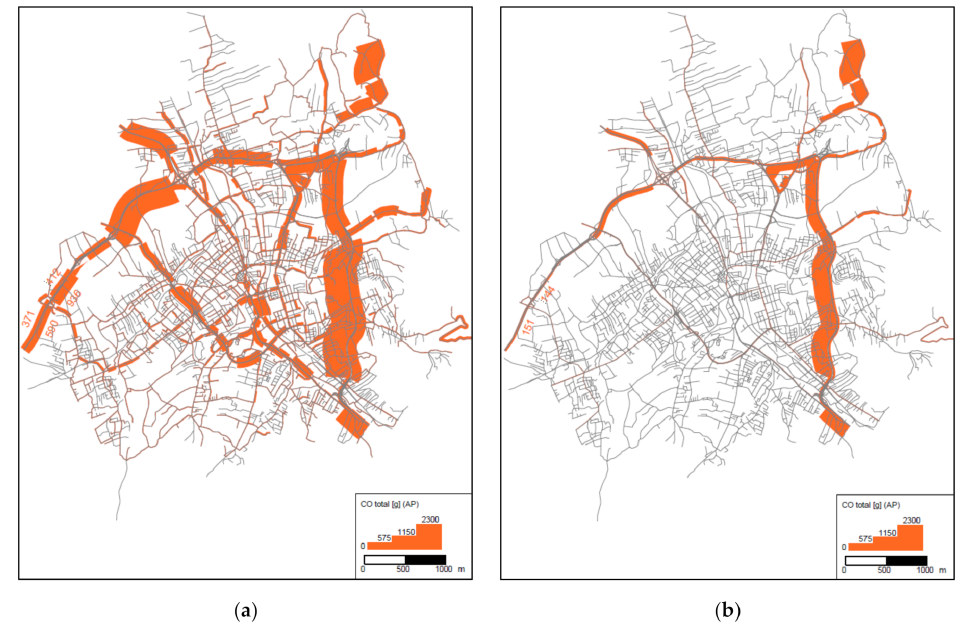
Figure 6. The assessment of CO total [g] (measure from Group 1) for scenario W0 and optimal scenario (W4)—analysis for the whole city: ( a ) measure for scenario W0; ( b ) measure for scenario W4.